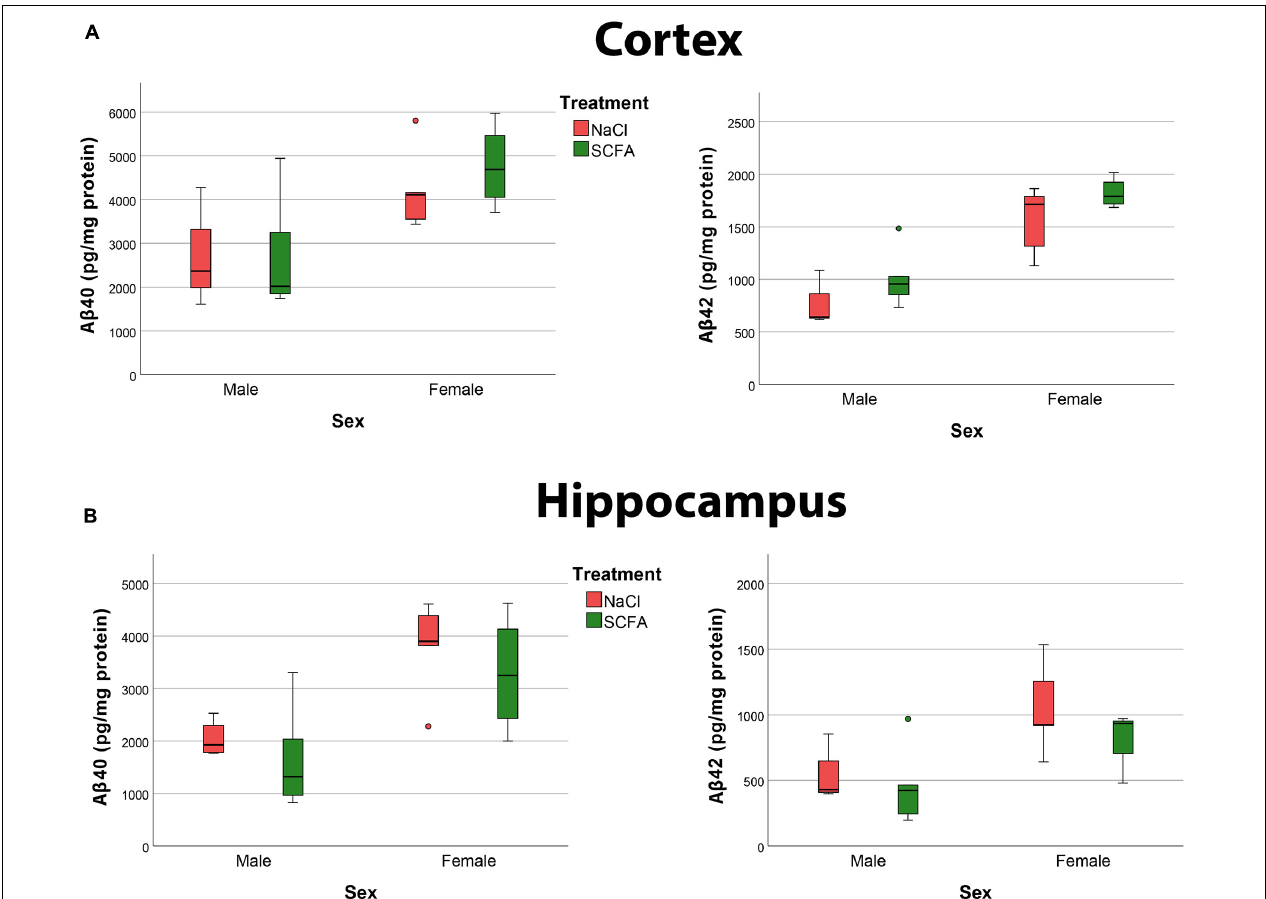
FIGURE 9 | Amyloid MSD indicates no significant effect of short chain fatty acids (SCFA) on A β 40 and A β 42 and confirm that female mice had significantly more A β . Quantification of A β 40 and A β 42 in the cortex (A) and hippocampus (B) reveals a significant difference with sex but not with SCFA treatment. Statistical significance was determined by using a general linear